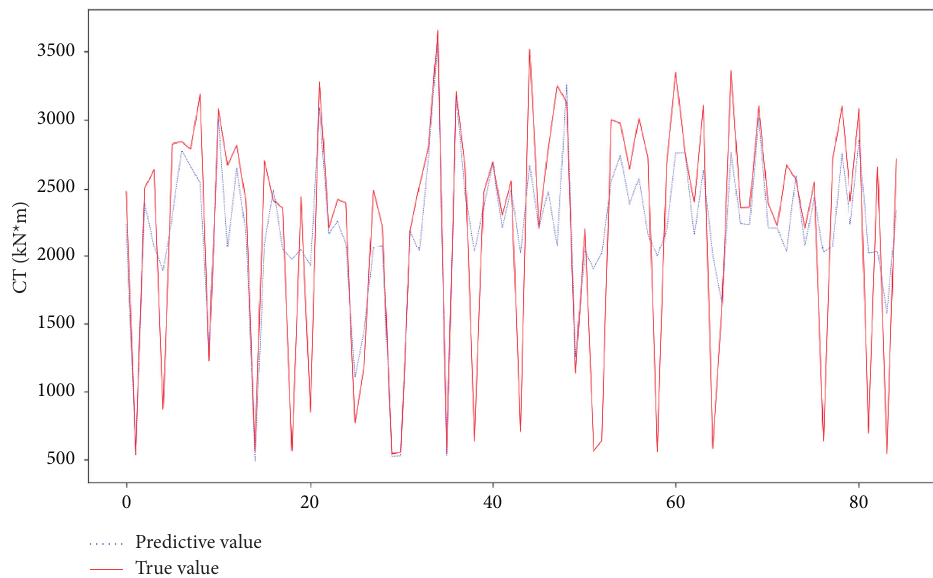
Figure 7: Effect of predicting cutterhead torque by using the SVR model on the testing dataset.